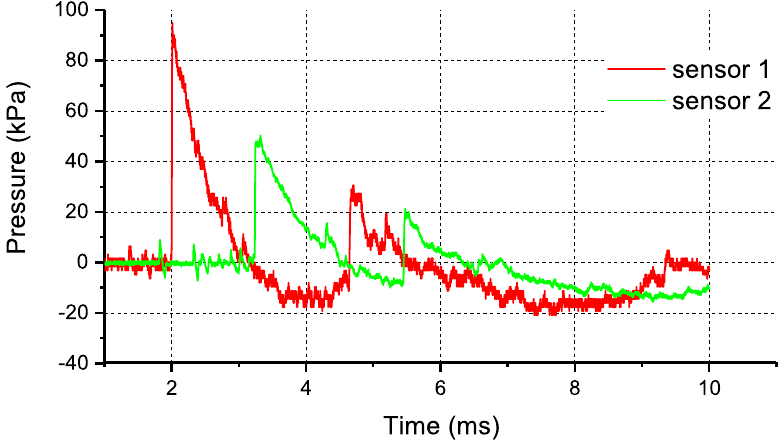
Figure 3. Sample pressure vs. time profiles for the detonation of OSM-0